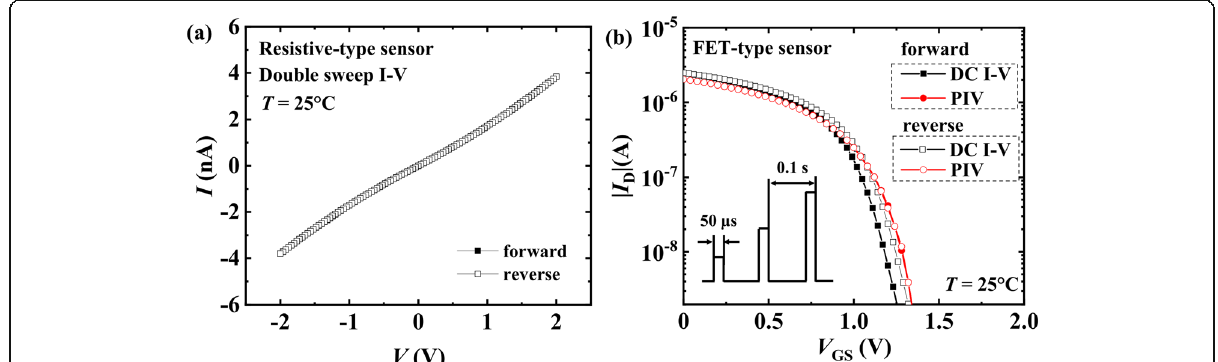
Fig. 3 Basic electrical properties of the resistive-type and FET-type Pt-In 2 O 3 sensors at T = 25 °C. a Double sweep I-V curve of the resistive-type sensor. The results of forward and reverse voltage sweeps overlap with each other. b Double sweep DC and pulsed I-V (PIV) curves of the FET- type sensor. The inset indicates the pulse scheme used for PIV measurement